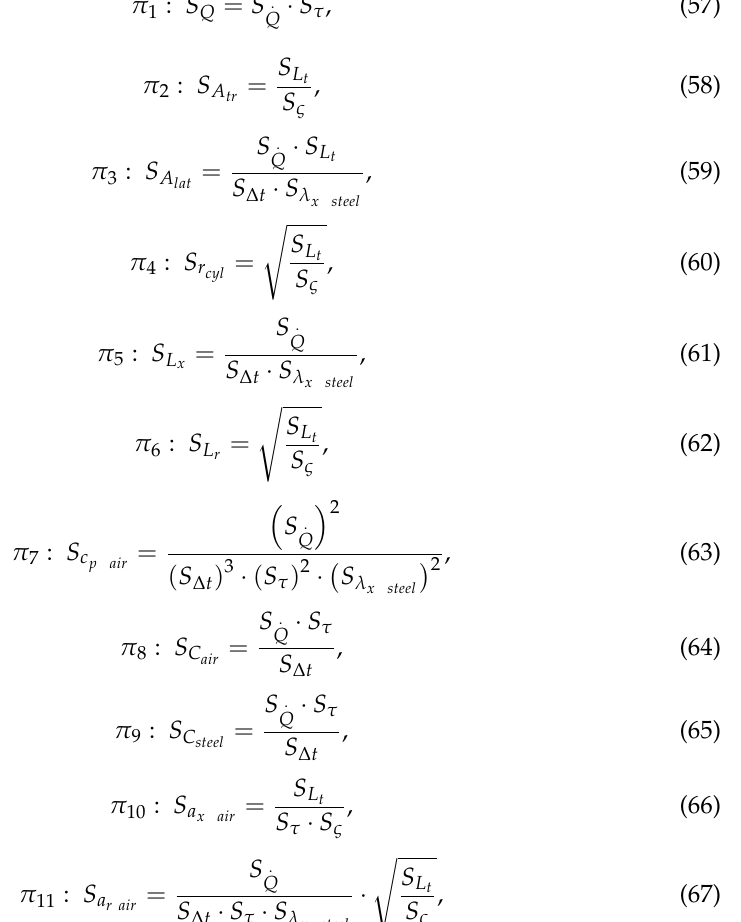
The corresponding elements of the model law